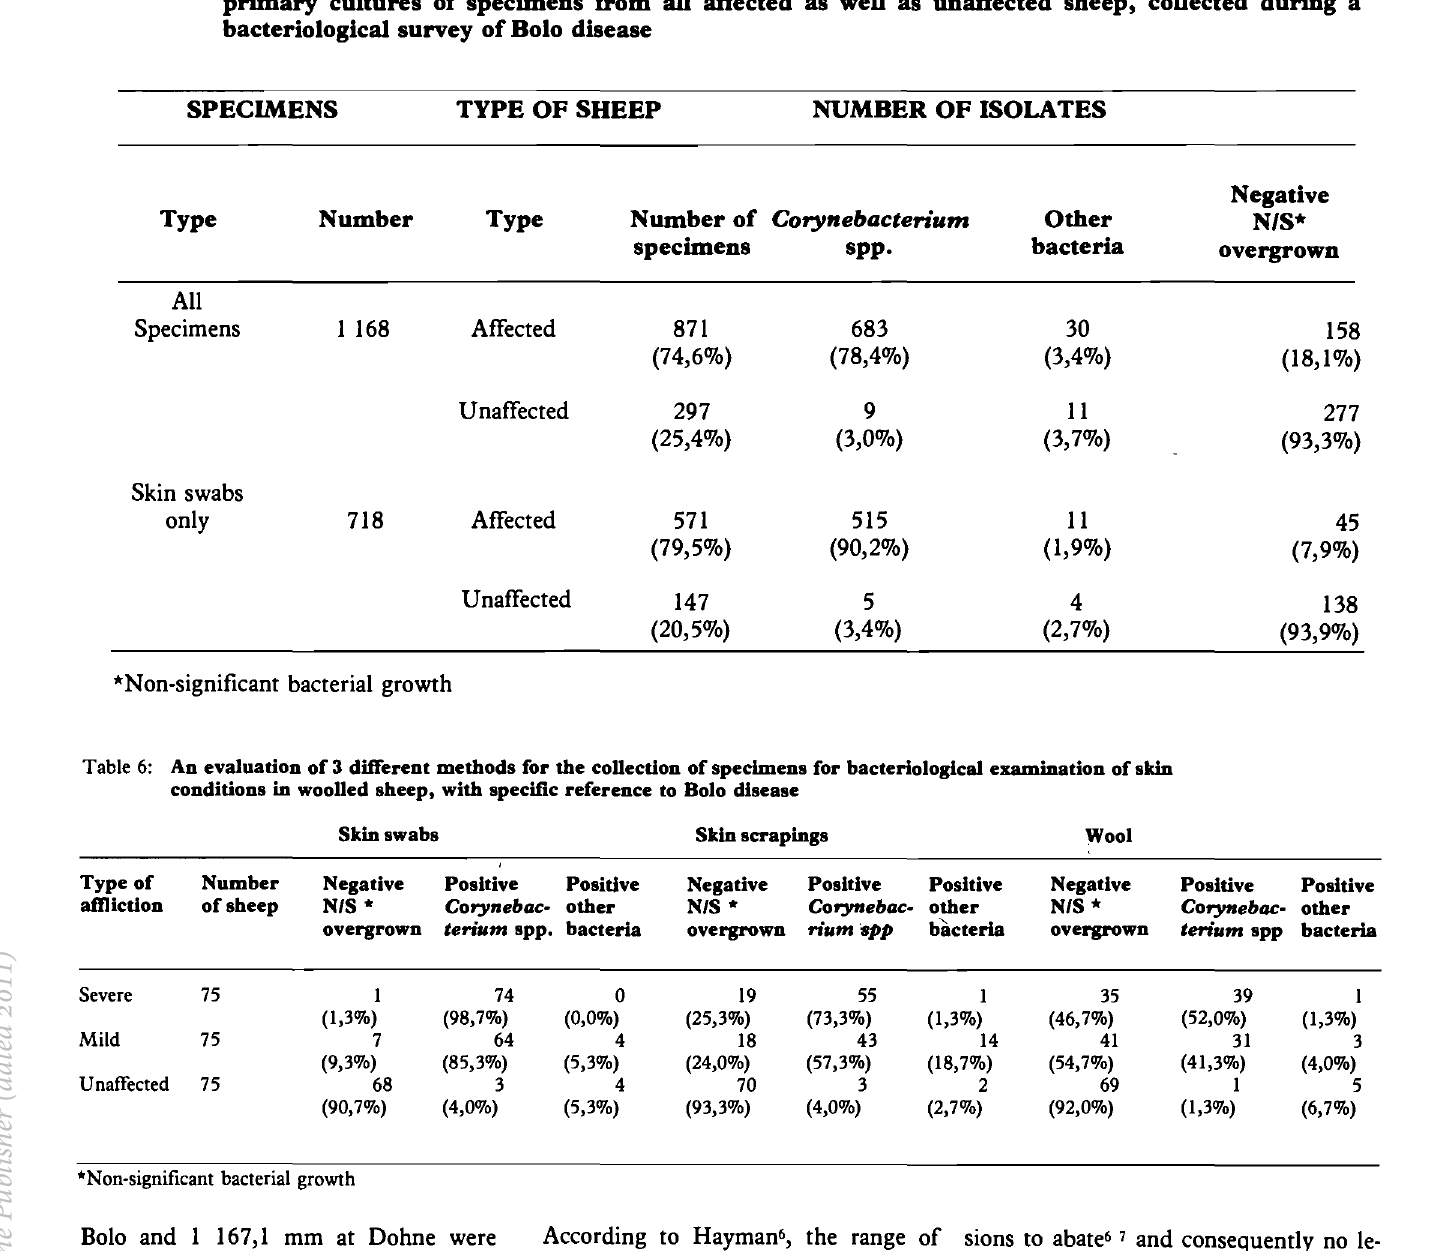
Table 5: Comparison of the total number of Corynebacterium spp. isolates to other bacteria recovered from primary cultures of specimens from all affected as well as unaffected sheep, collected during a bacteriological survey of Bolo disease